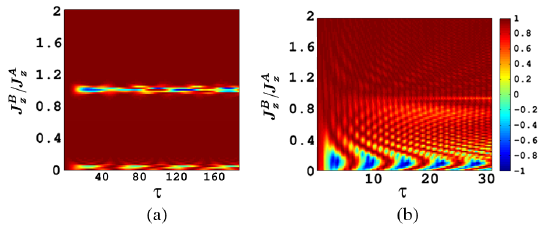
FIG. 3 (color online). Rabi nutation of two coupled qubits in the geometry of Fig. 1(b), where both qubits are initialized in their j 0 i states. Qubit A is driven at its level splitting J A z with a Rabi frequency ϵ ¼ 0 . 03 J A z , and qubit B is coupled to A with a coupling constant J AB . Time τ is in periods of the free preces- sion of A . The color scale is the value of S B z between − 1 and